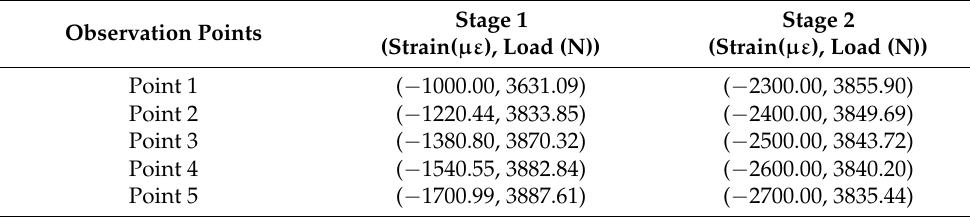
Table 2. Observation site information in property identification